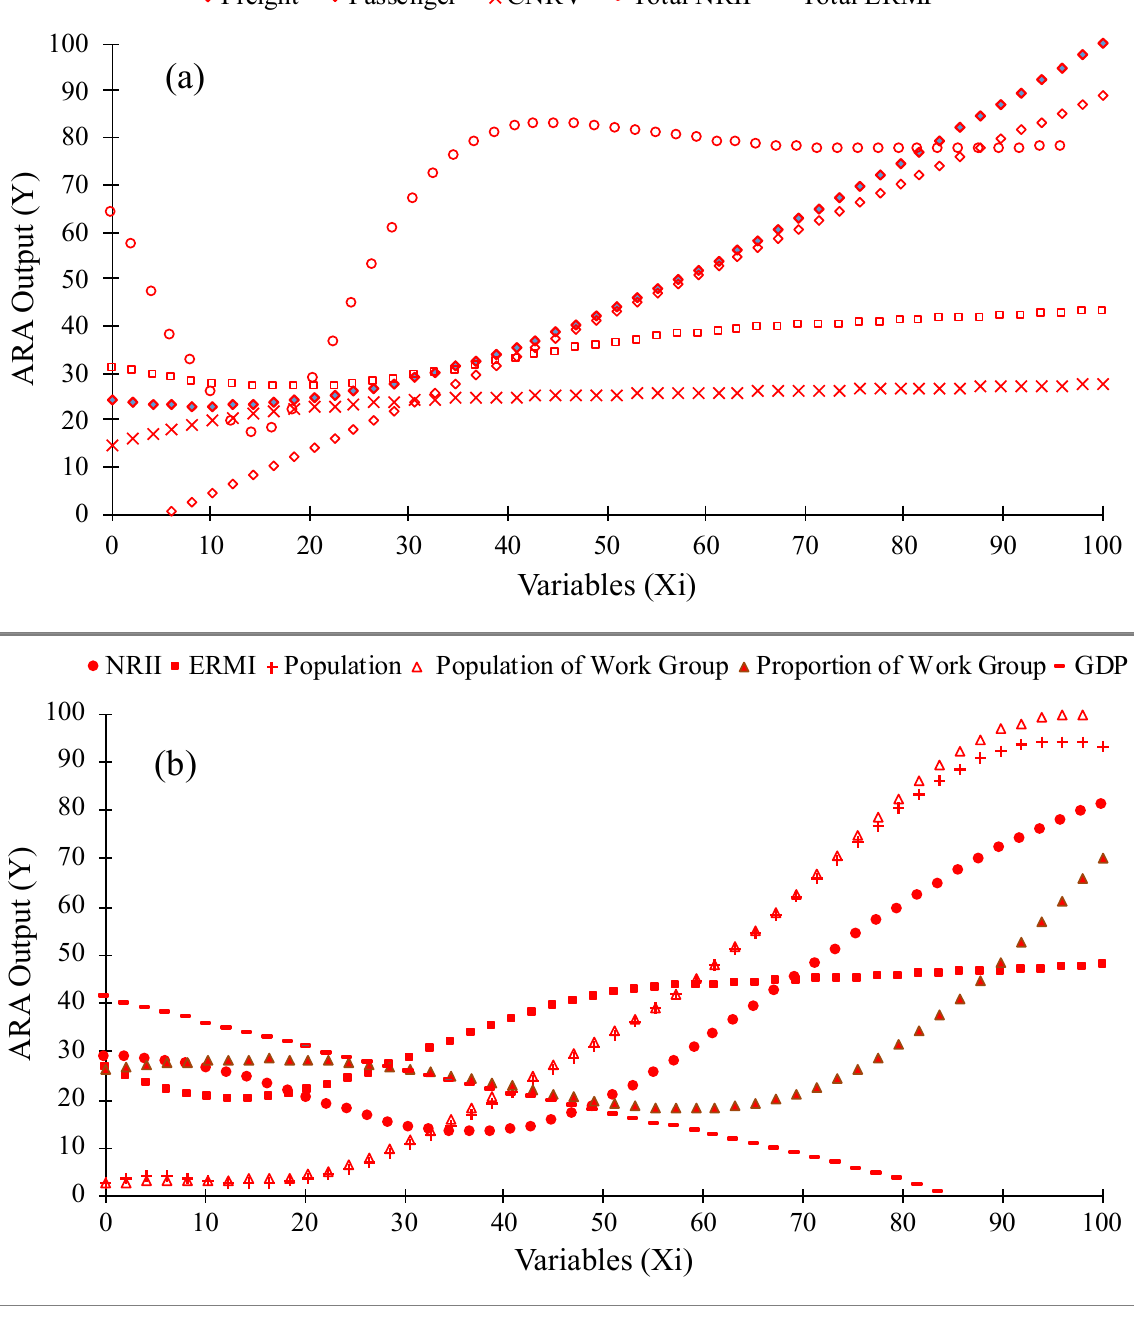
Figure 6. Sensitivity and general variation trend of ARA with predicting variables: ( a ) Part I, ( b ) Part II.